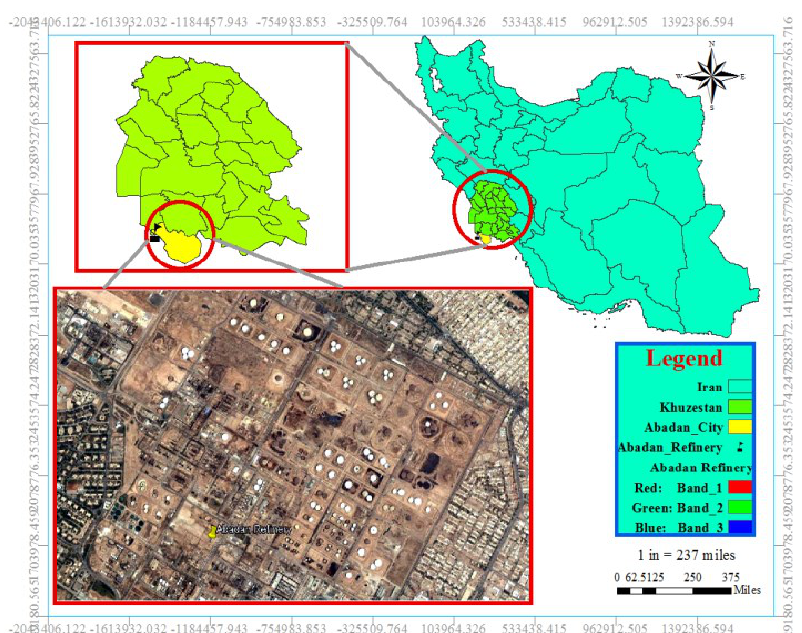
Fig. 1. Geographic location of study